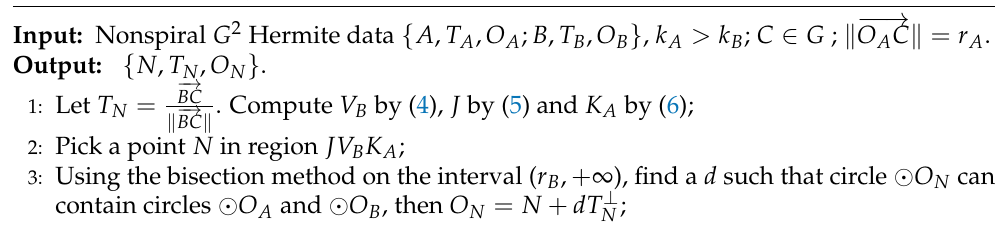
(cid:107)−−→ O A C (cid:107) = r A (see Figure 10c)